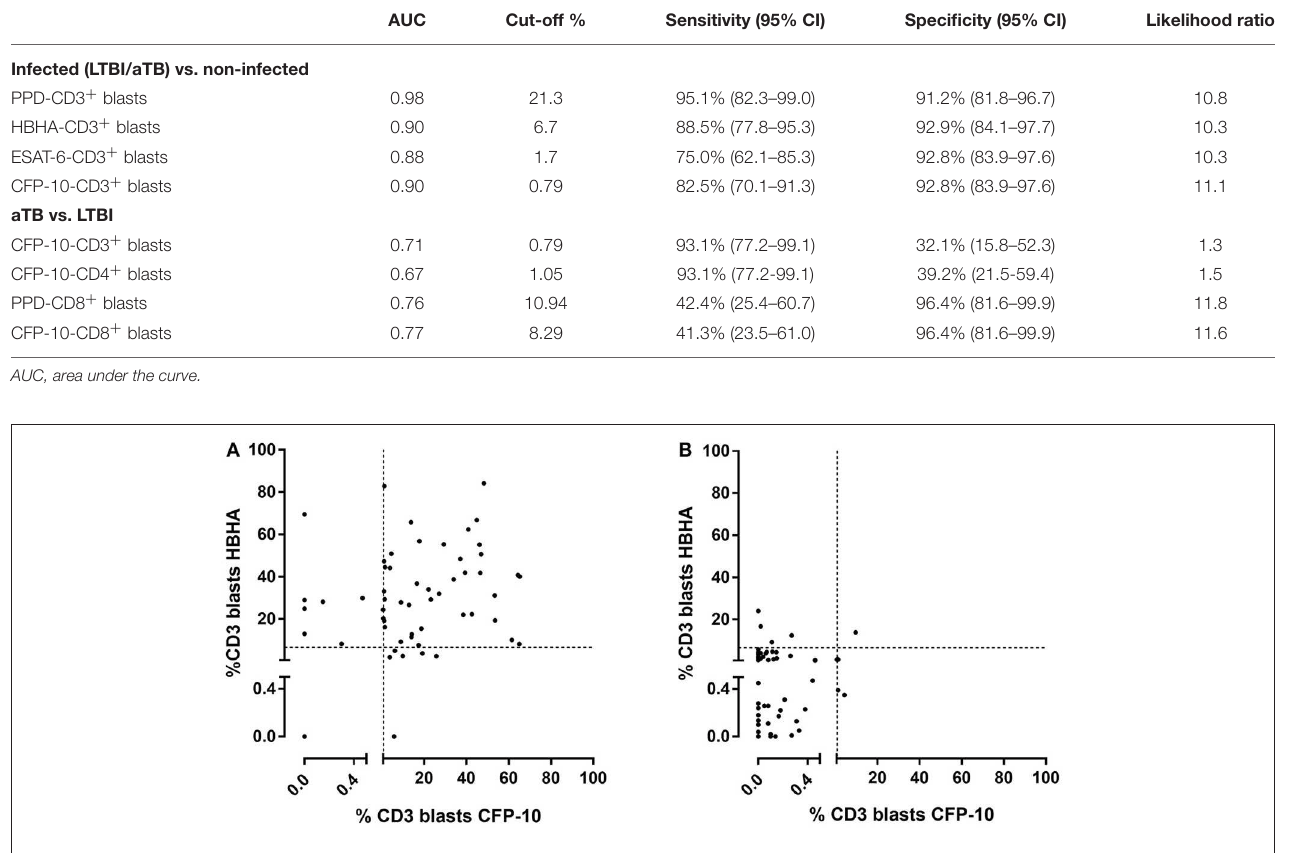
FIGURE 3 | Combined analysis of the percentages of HBHA- and CFP-10-induced CD3 + blasts in M. tuberculosis -infected children (LTBI/aTB). Ten-fold diluted whole blood was incubated during 7 days at 37 ◦ C with HBHA (10 µ g/ml) or CFP-10 (5 µ g/ml), as indicated, before labeling the cells with anti-CD3 monoclonal antibody and analysis of the percentages of CD3 + blasts by flow cytometry. (A) Results from M. tuberculosis- infected children (LTBI and aTB combined), and (B) results from non-infected children, each symbol representing the value obtained for an individual subject after deduction of the percentage obtained in the non-stimulated condition. The dotted lines indicate the cut-offs chosen for the two